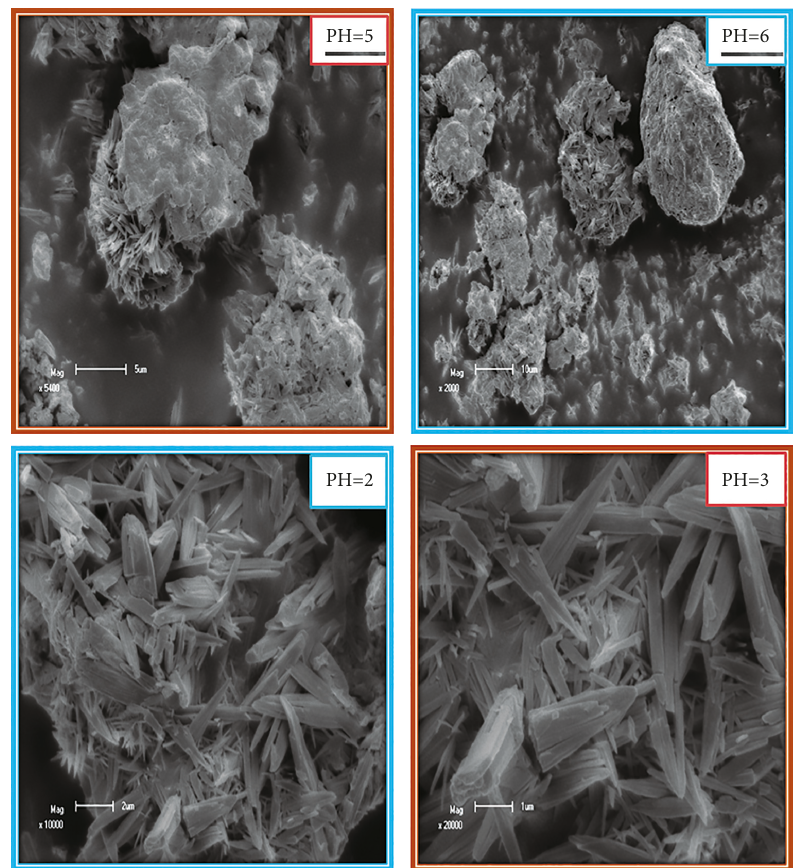
Figure 3: SEM images of synthesized Fe: TiO